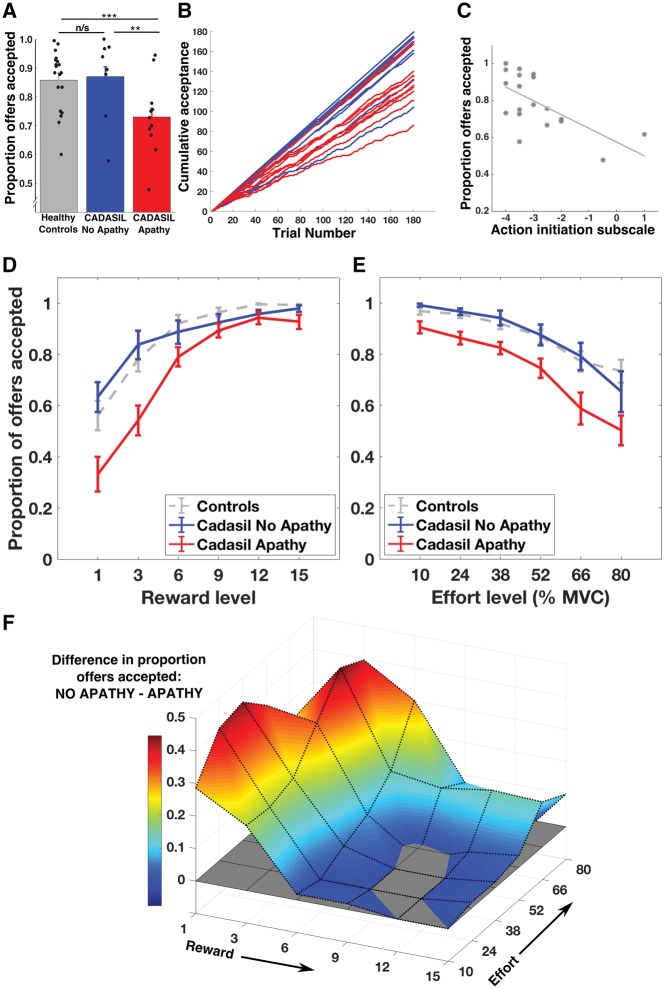

Effort-based decision-making in CADASIL apathy. (A and B) Apathetic patients accepted significantly fewer offers than non-apathetic patients or healthy controls. (C) The proportion of offers accepted was significantly correlated with the action initiation subscale of the LARS. (D) There was a significant apathy × reward interaction on offer acceptance. This plot shows the proportion of offers accepted as reward increases (collapsed across effort). Apathetic patients accepted fewer offers when rewarding outcomes were low, but performed the same as non-apathetic patients when rewards were high. (E) In contrast, there was no apathy × effort interaction. This plot shows offer acceptance as effort level increases (collapsed across reward). (F) The difference in offers accepted between no apathy and apathy groups occurred in a distinct region of decision space—where offers were for low rewards, irrespective of effort required. A, D and E show mean ± SE. **P < 0.05; ***P < 0.01; n/s = not significant.